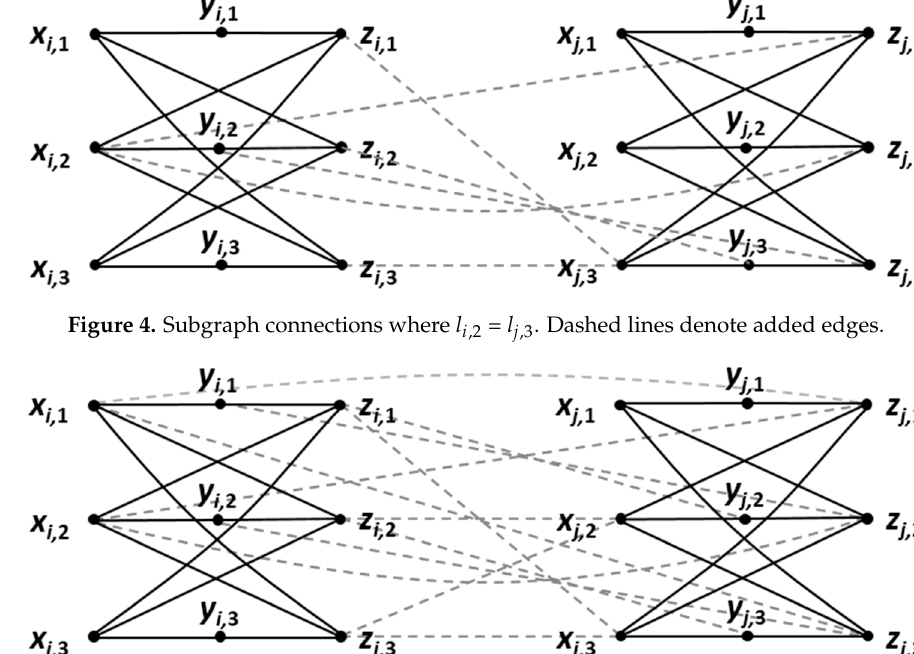
Figure 5. Subgraph connections where l i ,1 = l j ,2 and l i ,2 = l j ,3 . Dashed lines denote added edges.